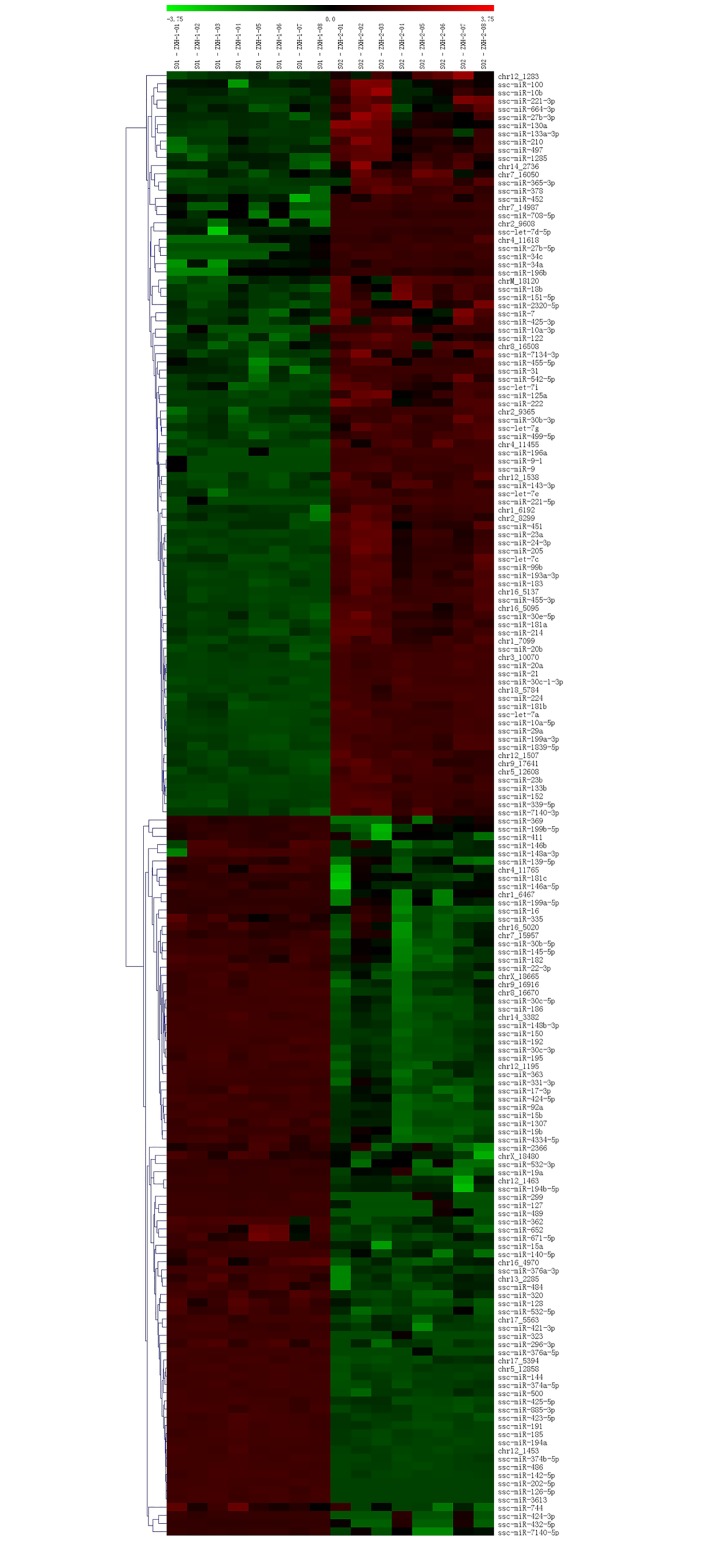
Heatmap of differentially expressed miRNAs in suckling and weaned piglets.Green indicates downregulated expression, and red indicates upregulated expression compared to a reference expression level.